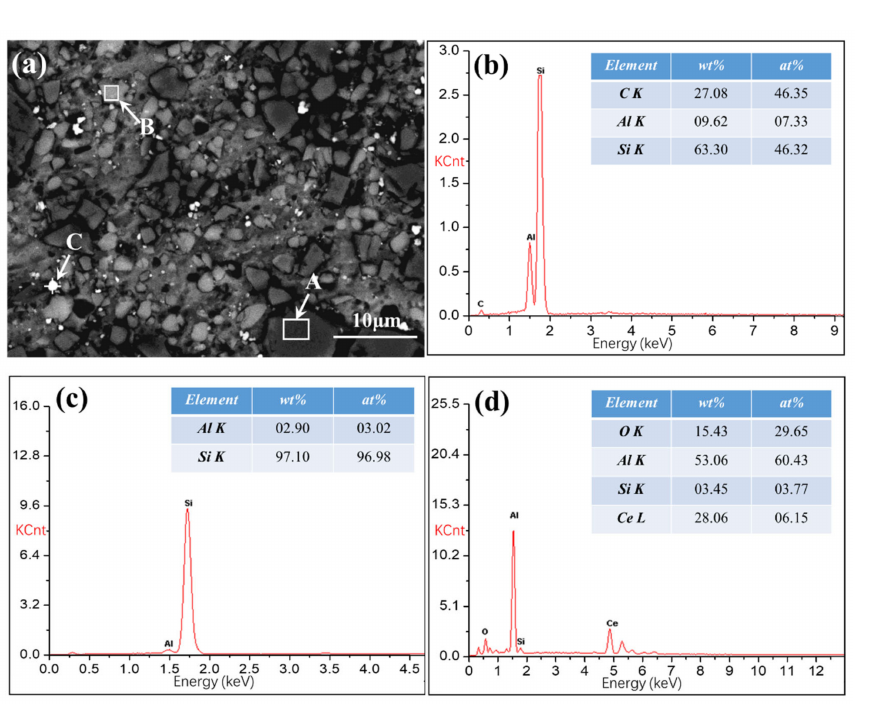
Figure 4. The scanning electron microscope (SEM) and energy dispersive spectrometer (EDS) of SiCp / Al-Si Composites with 0.6 wt% CeO 2 : ( a ) the SEM of diagram organization; ( b ) the energy spectrum diagram of region A; ( c ) the energy spectrum diagram of region B; ( d ) the energy spectrum diagram of point